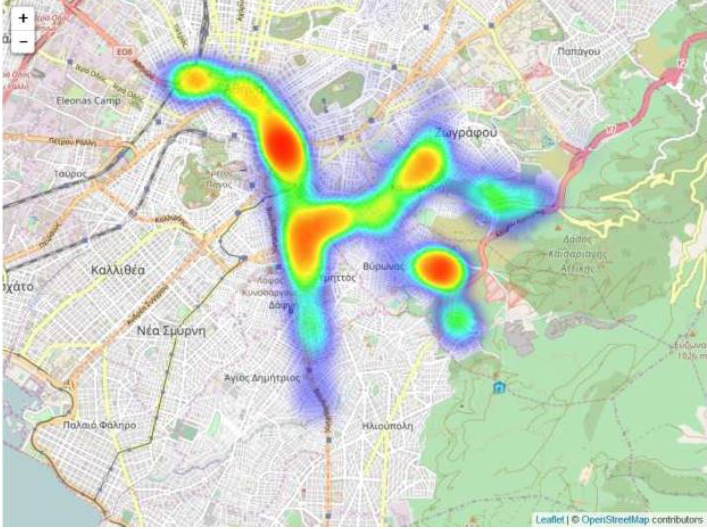
Figure 7. Global Environmental Quality Assessment map,